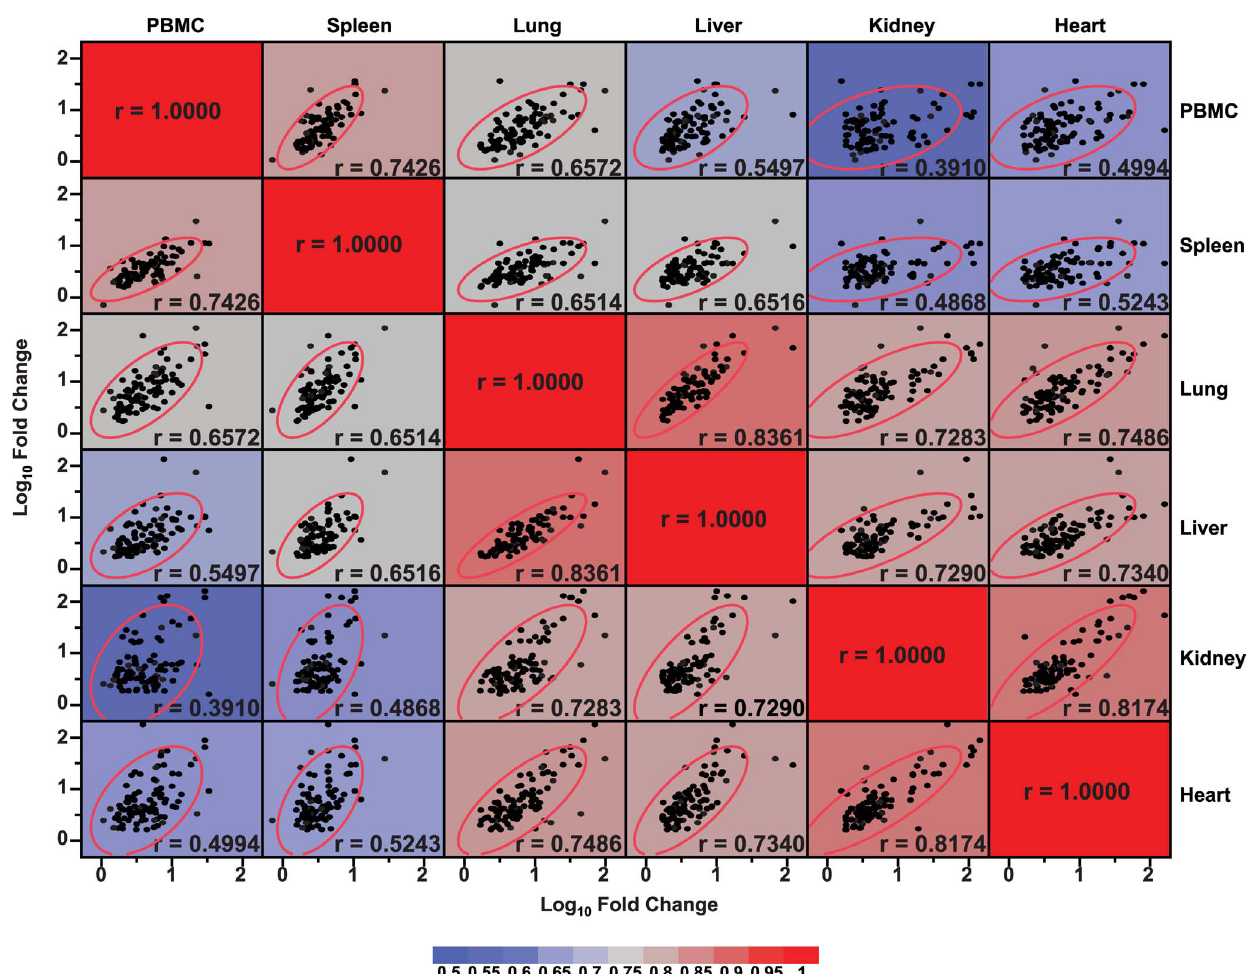
Figure 3. Correlation matrix of gene expression levels by tissue type. Expression levels of 103 probesets are shown as log 10 fold-change relative to control (saline-exposed) animals at 24 h after staphylococcal enterotoxin B (SEB) challenge. Tissue-to-tissue comparisons using Pearson’s correlation are represented numerically by r-values and in shades of red (higher correlation) and blue (lower correlation). Tissue/organ pairs with the closest patterns of gene expression were PBMC/spleen, lung/liver, and kidney/heart.